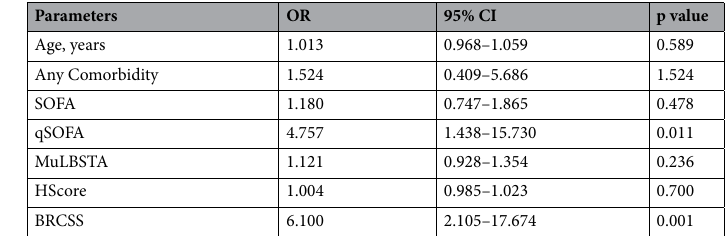
Table 3. Evaluation of the parameters of all patients according to the severity of disease with multivariate logistic regression analyses at the time of admission. SOFA Sequential organ failure assessment score, qSOFA quick sequential organ failure assessment score, MuLBSTA multilobularinfiltration, hypo-lymphocytosis, bacterial coinfection, smoking history, hyper-tension and age score, HScore hemophagocytosis score, BRCSS Brescia respiratory covid severity scale.